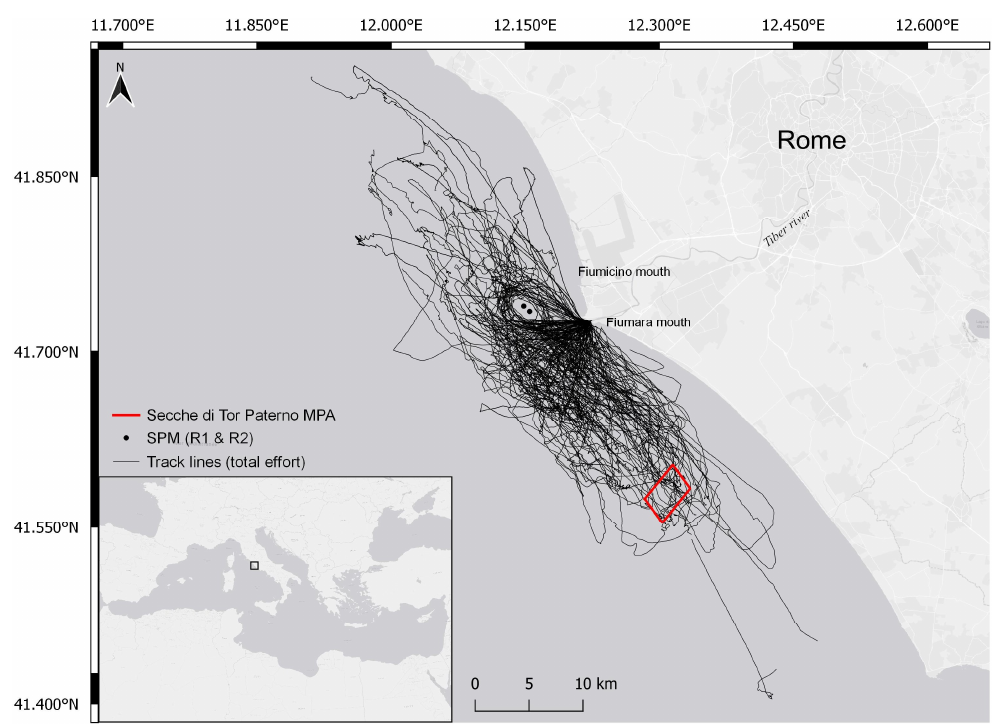
Figure 1. Study area in Central Tyrrhenian Sea: black lines represent the tracks made in the period 2017–2020, black dots represent single-points mooring (SPM), and the red square identifies Secche di Tor Paterno (marine protected area, MPA).